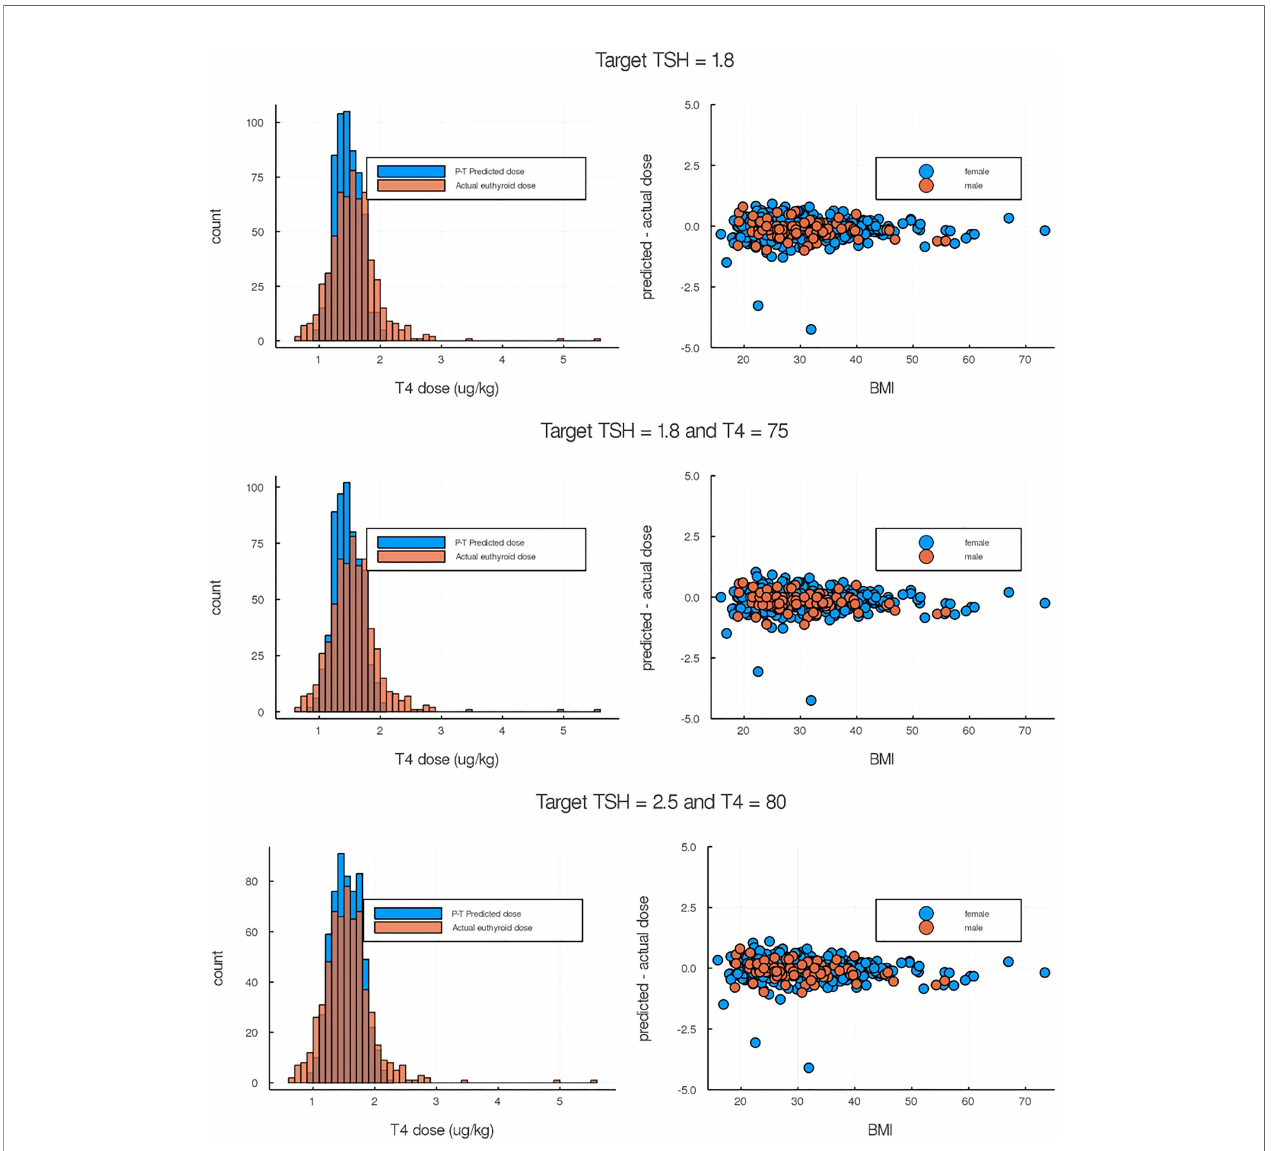
FIGURE 5 | Comparison of p-THYROSIM simulated results against data not used in model fi tting. Left-side plots are the histogram distributions of predicted LT4 dose compared to the true euthyroid dose from individual patient data (14). Right-side plots are the differences between predicted and euthyroid doses as a function of BMIs. (Top) p-THYROSIM prediction based purely on TSH criteria (1.8 mIU/ml as target). (Middle and Bottom) p-THYROSIM predictions based on both TSH and T4